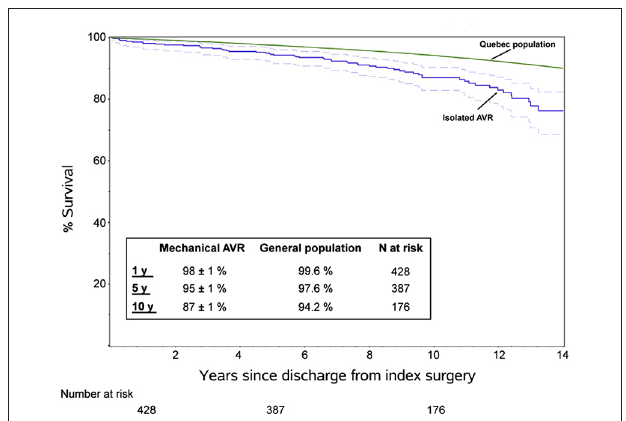
FiguRe 1 | Survival in young adults undergoing isolated mechanical AVR compared to sex and age matched population (Bouhout et al.) (7) (printed with permission from